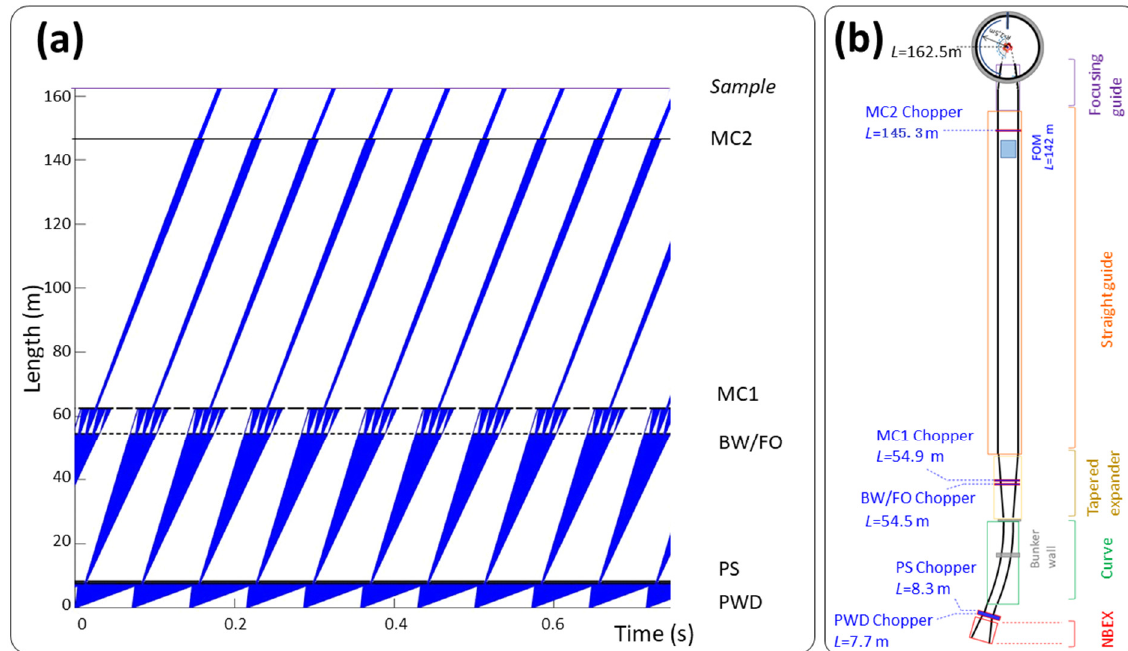
Figure 3. ( a ) Time structure diagram and ( b ) sketch of the beamline layout, showing the current chopper cascade of MIRACLES, plus the two slow MC bandwidth choppers which are needed to propagate a “clean elastic band”.